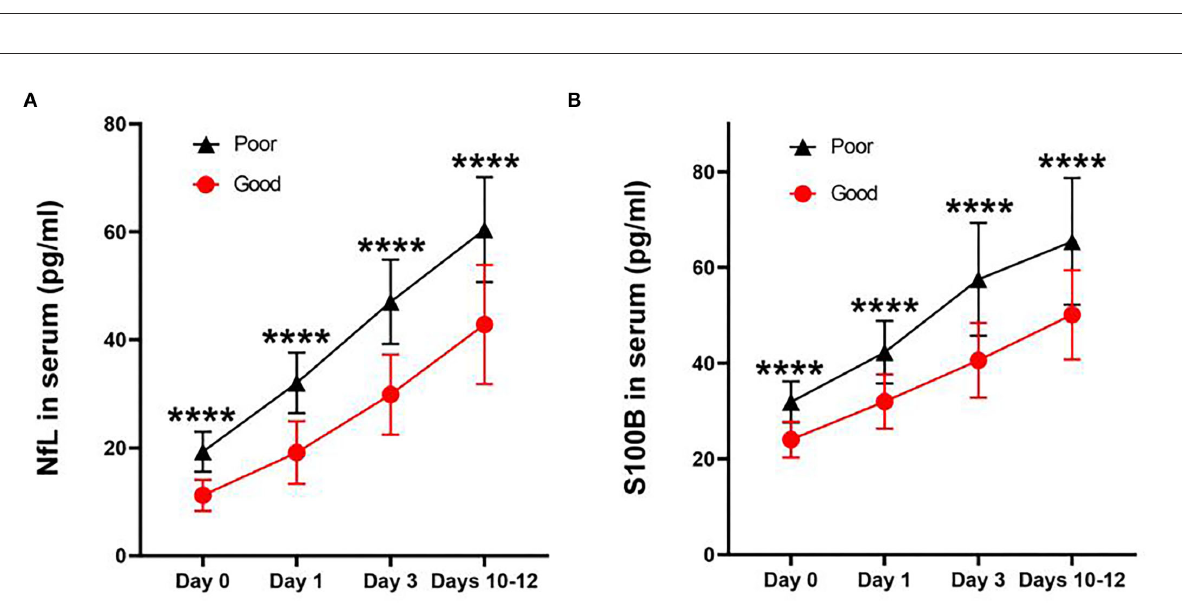
FIGURE4 Line charts of concentration of NfL (A) and S100B (B) in serum after aneurysmal subarachnoid hemorrhage at each time point. Both concentrations were significantly higher in those with poor outcomes than in good outcomes ( P < 0.0001). All data were presented as mean ± SEM. **** P <